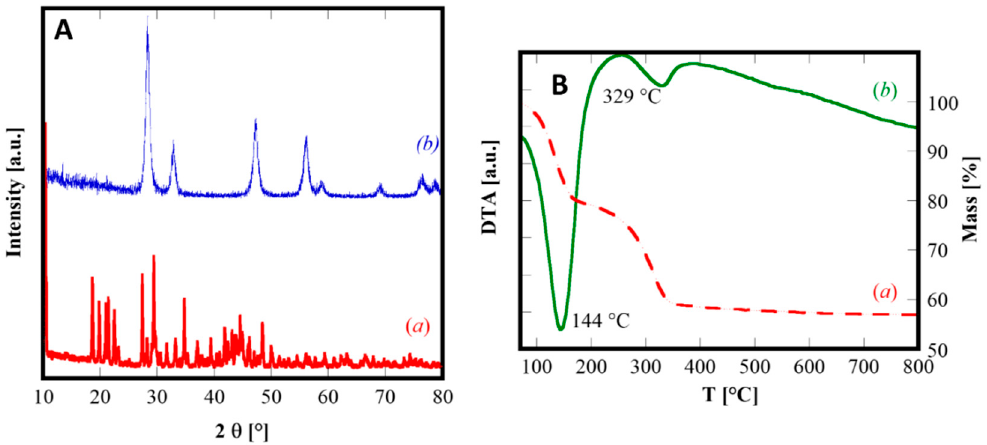
Figure 5. XRD patterns ( A ) of as-synthesized (a) and calcined (b) and DTA-TGA curves ( B ) of SDC20R10S sample.